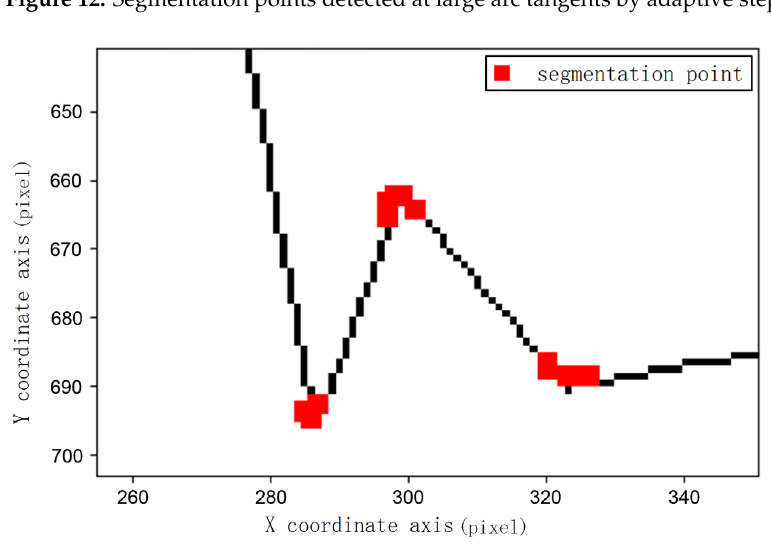
Figure 13. Segmentation points detected at shorter graphic elements by adaptive steps.